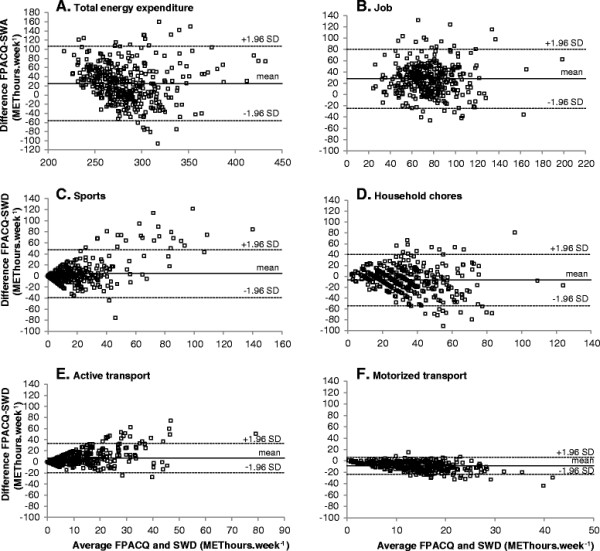
Bland-Altman plots for total energy expenditure (A) and energy expenditure during job activities (B), sports (C), household chores (D), active transport (E) and motorized transport (F), as assessed with the FPACQ on the one hand and the SenseWear Armband in combination with an electronic activity diary (SWD) on the other.